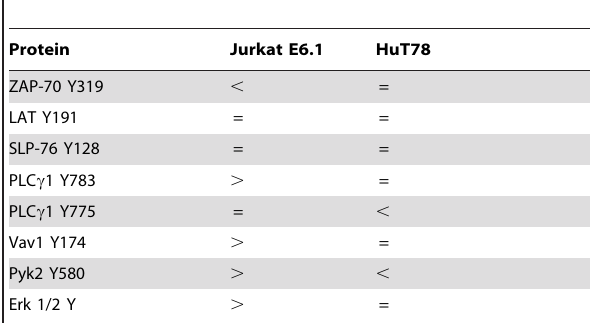
Table 2. Expression of surface receptors in Jurkat E6.1 T cells, HuT78 T cell, and APBTs. Table 3. Phosphorylation per protein in Jurkat E6.1 and HuT78 cell lines as compared to